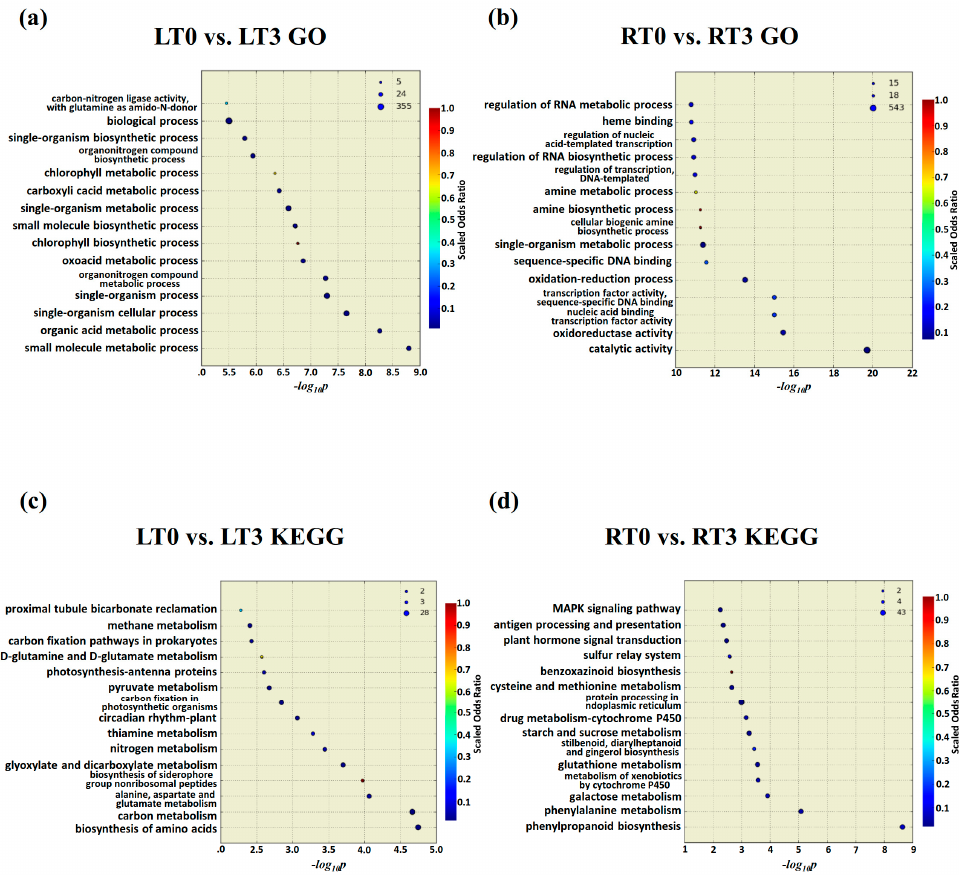
Figure 5. GO and KEGG enrichment analysis of all DEGs following CdCl 2 exposure at T3 vs. T0 in leaves ( a , b ) and roots ( c , d ).